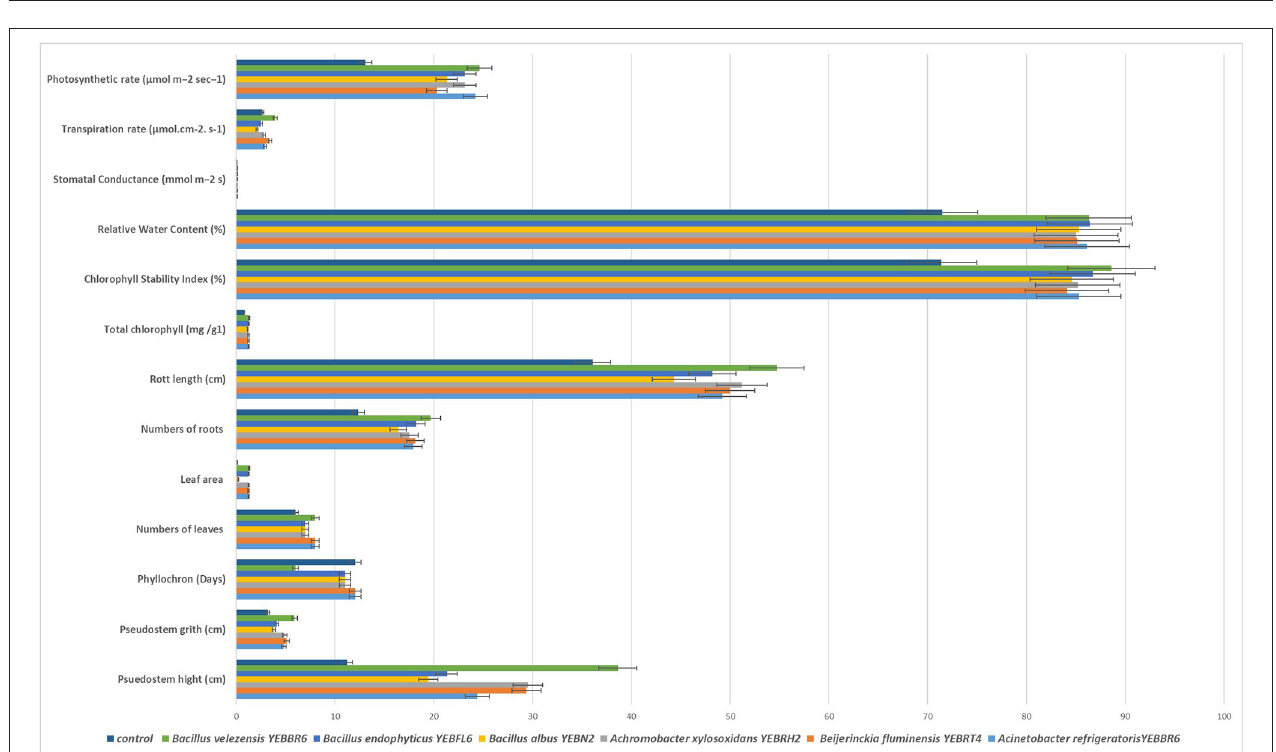
FIGURE 2 | Phenotypic response and plant growth promotion of micropropagated banana plantlets biohardened with bacterial endophytes.